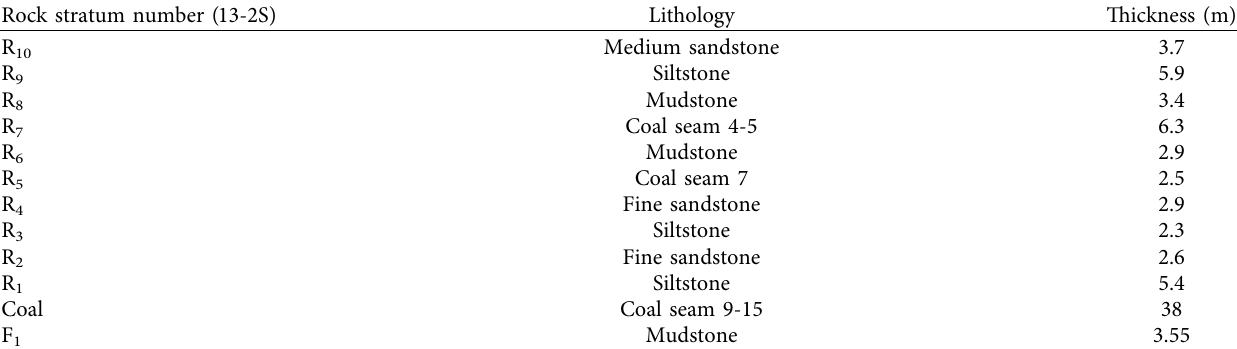
Table 1: Rock structure of borehole in LW (4-5)04.